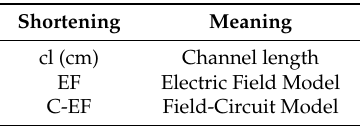
Table 1. A list of acronyms and their meaning.